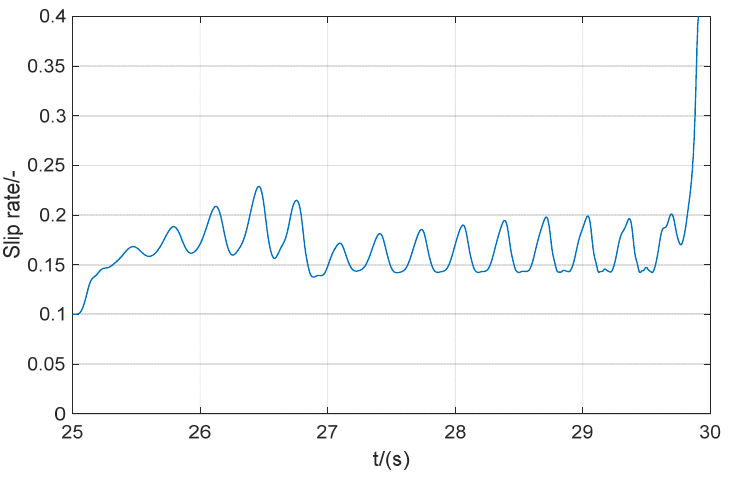
Figure 15. The slip rate curve.